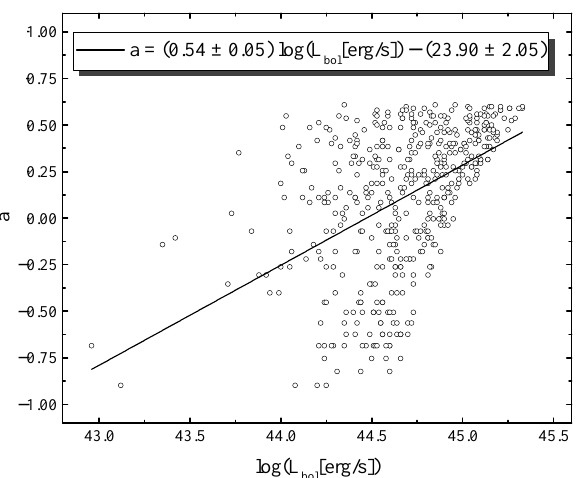
Figure 10. The dependence of the estimated spin values a on the bolometric luminosity L bol .